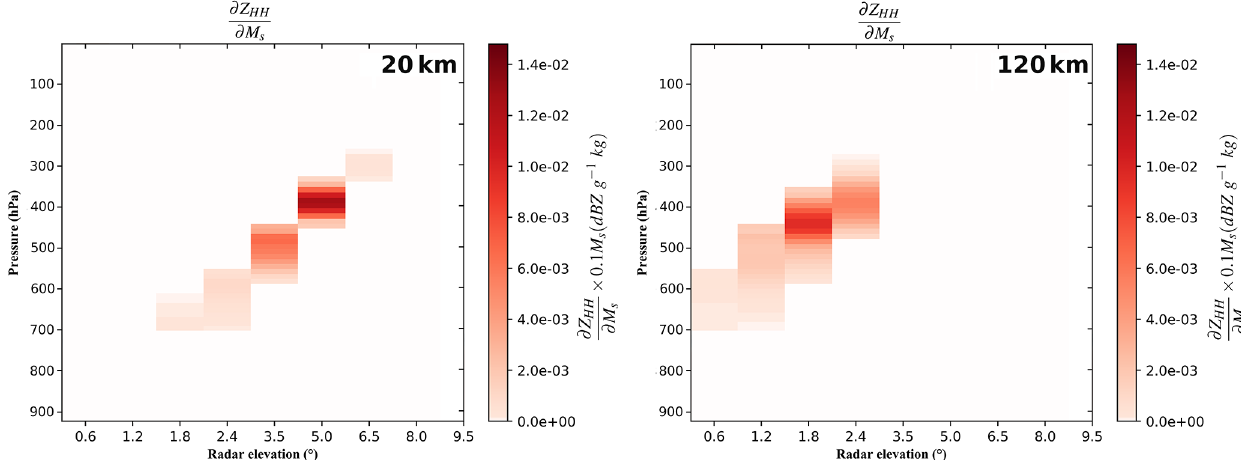
Figure 12. Z HH Jacobian for a snow content perturbation associated with the AROME hydrometeor profile shown in Fig. 10, artificially located at (a) 20km and at (b) 120km from the radar. The Jacobians are normalized by 10% of the hydrometeor